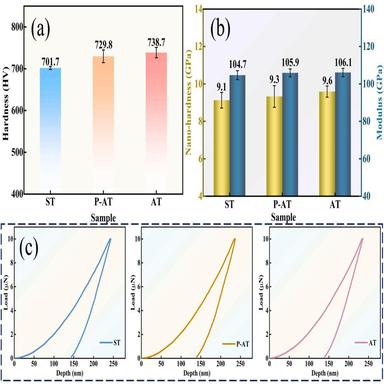
Mechanical properties of Ni55Ti37Hf8 alloy after different heat treatments. (a) Vickers hardness, (b) Nano-hardness and elastic modulus (c) Loading/ unloading curves of alloys.